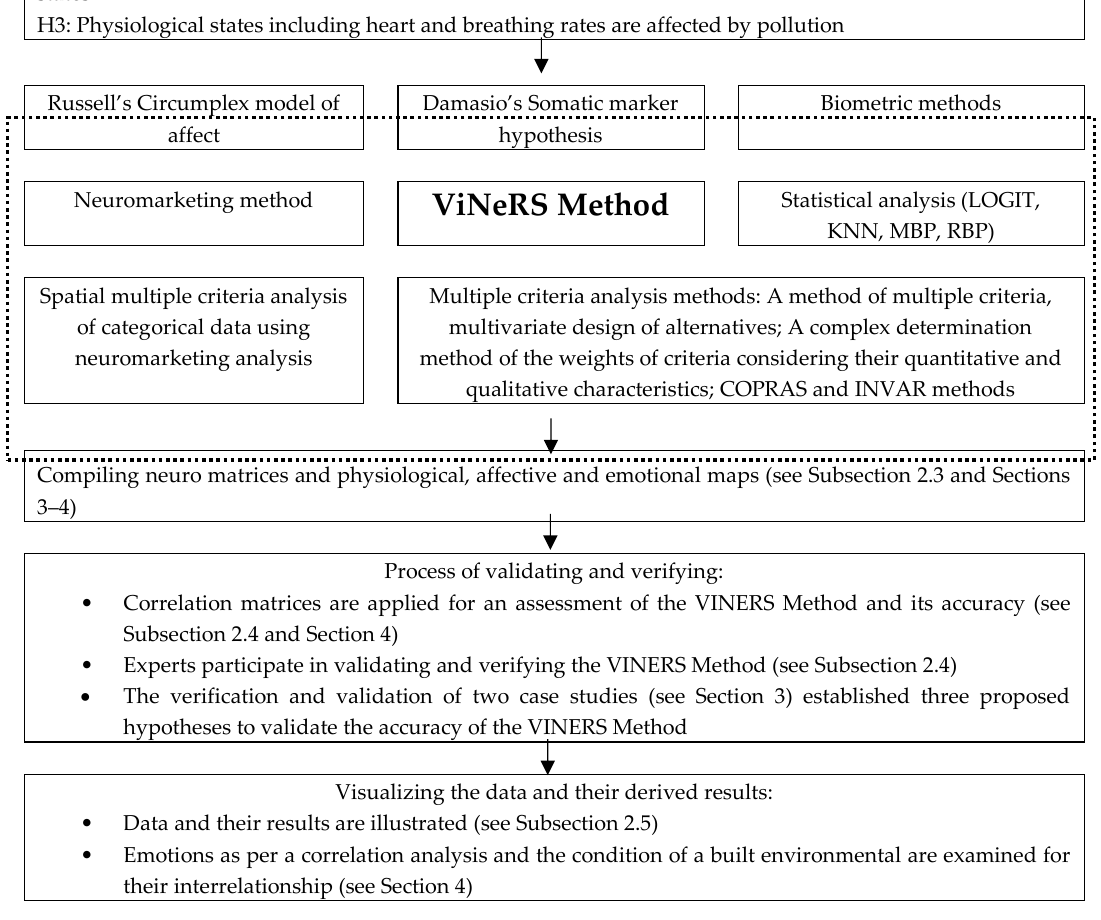
Figure 2. Main phases of the Video Neuroadvertising Recommender System (ViNeRS) Method.